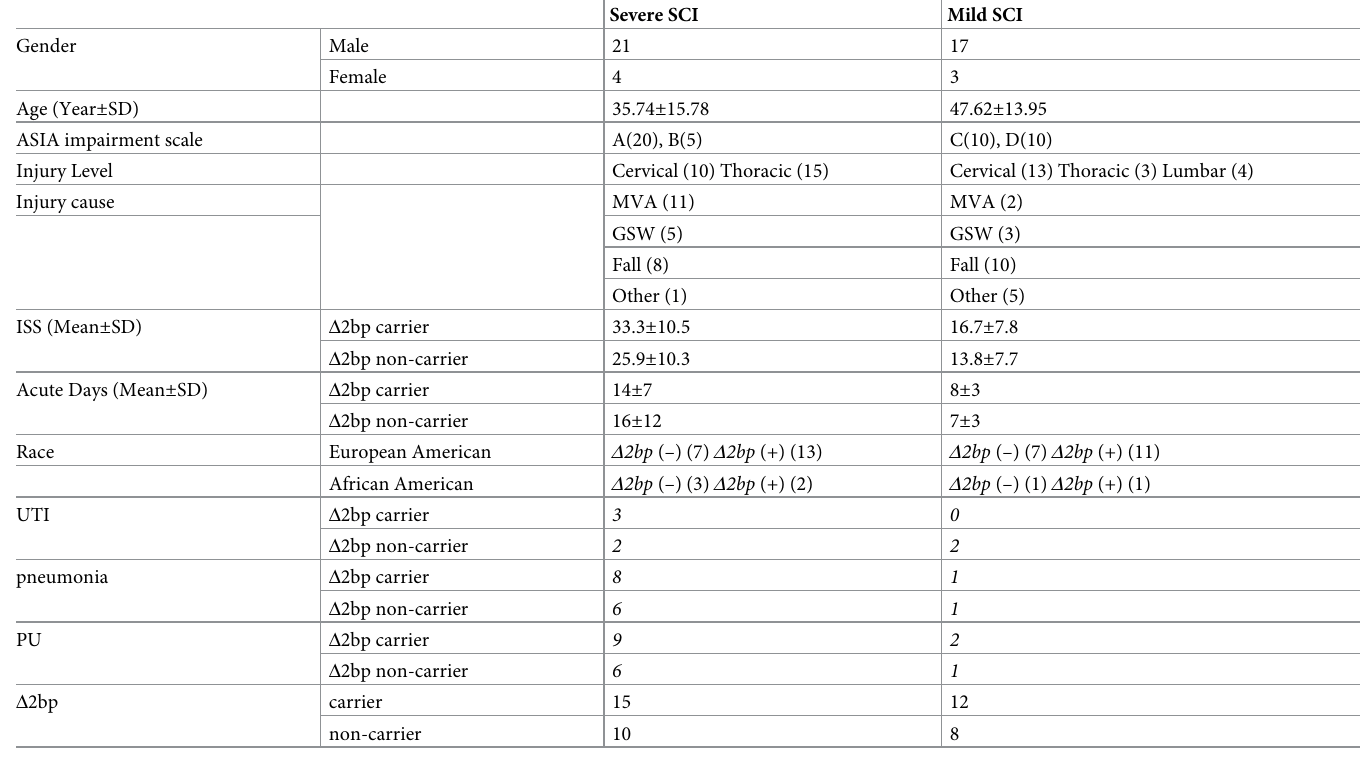
Table 1. Demographics of the SCI study population and Δ 2bp genotype status of subjects for the CHRFAM7A Δ 2bp variant. SD: standard